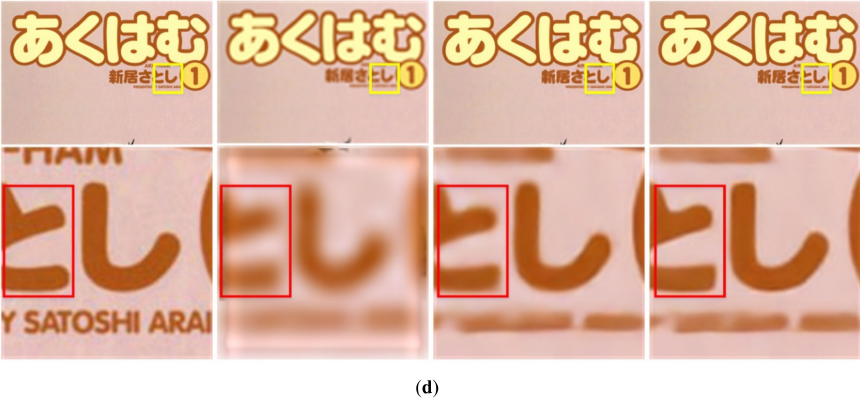
Figure 9. Visual comparison of the super-resolution (SR) images obtained using the PMSRN, MSRN, and Bicubic technique using DIV2K as the training set and different r values. Each group of images is shown from left to right, including the HR, Bicubic, MSRN, and PMSRN images. Compared with the other methods, the PMSRN produced an SR image with higher definition. The up-sampling factors r values are ( a ) 2, ( b ) 3, ( c ) 4, and ( d ) 8.